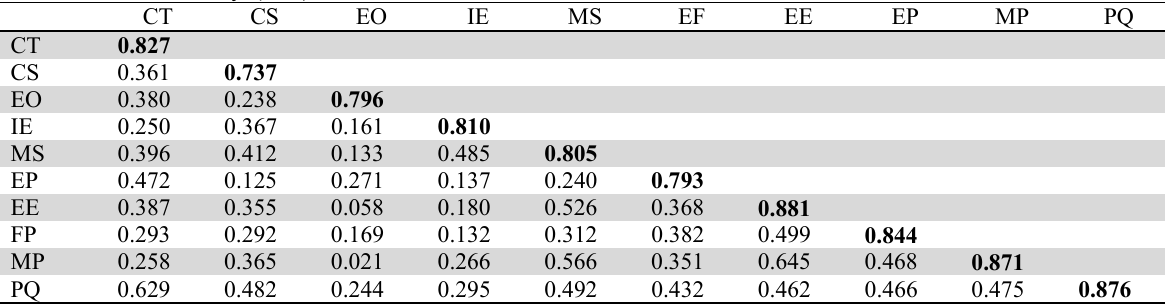
Discriminant Validity (DV)